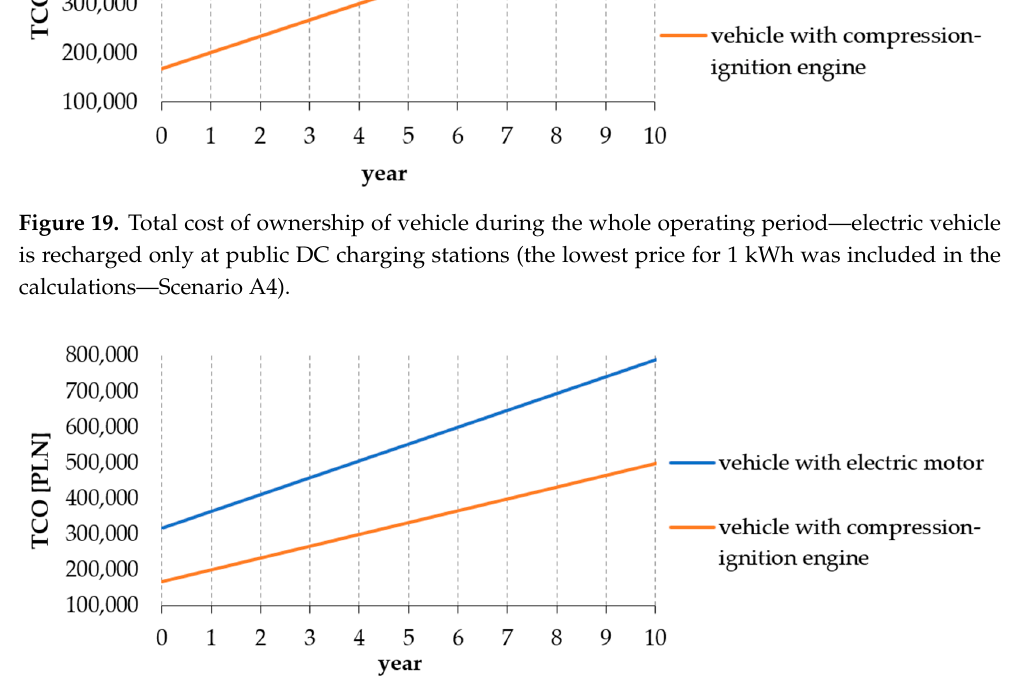
Figure 20. Total cost of ownership of vehicle during the whole operating period—electric vehicle is recharged only at public DC charging stations (the highest price for 1 kWh was included in the calculations—Scenario A5).